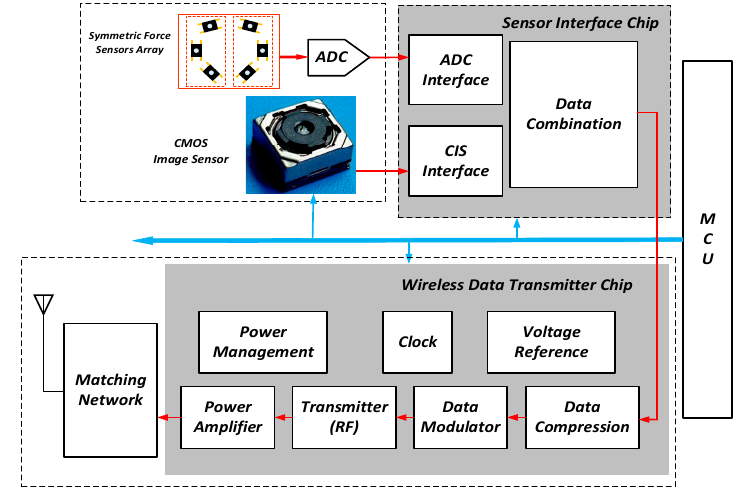
Figure 4. Functional diagram of the multimodal sensing device.